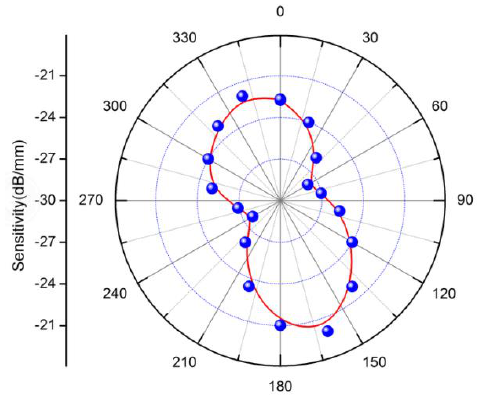
Figure 6. Angular dependence of the displacement responsivity of the sensor.